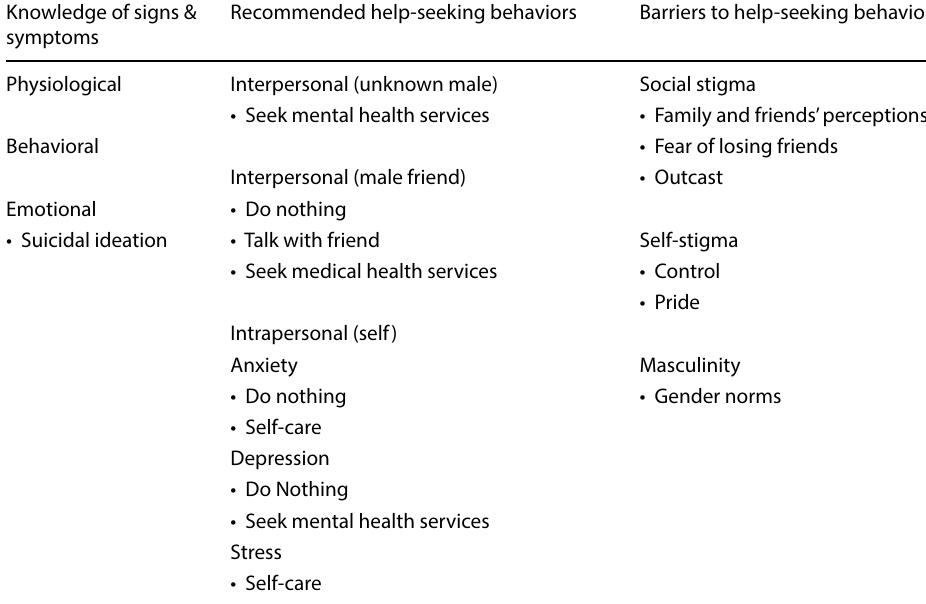
Table 3 MHL themes and subthemes among